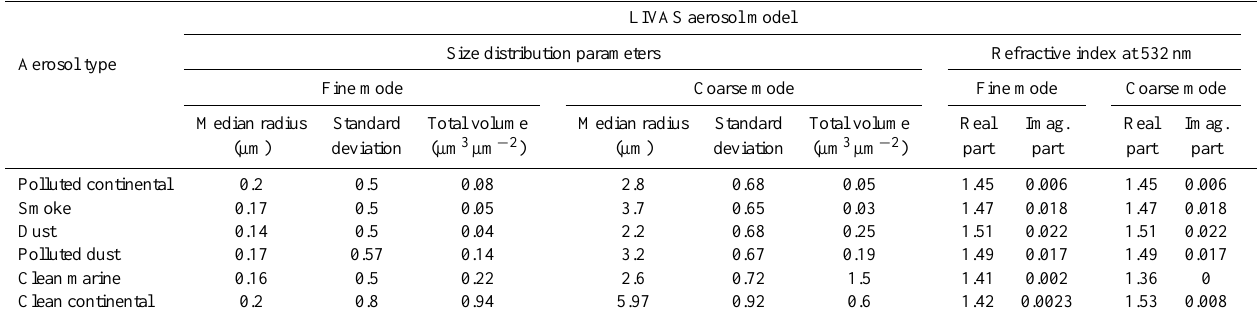
Figure 1. The data and methods used for the derivation of LIVAS BAEs and EAEs in the UV and IR spectral ranges. Table 1. LIVAS aerosol